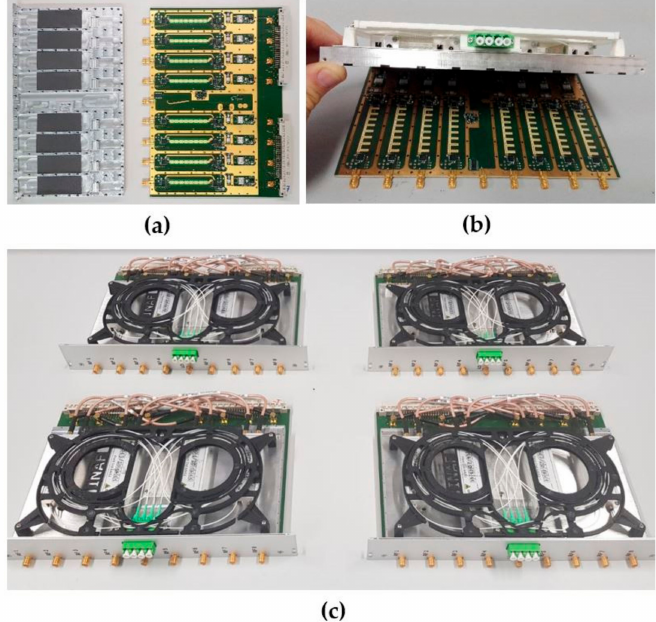
Figure 13. Photos of the WS RF / IF module. ( a ) Mechanical housing (Left) and PCB (Right) before assembly. Microwave absorbers are glued in the pockets of the PCB mechanical housing to mitigate cavity resonances on the RF circuitries. ( b ) PCB board (first prototype version) and mechanical housing during assembly with optical transmitters. ( c ) Four fully assembled WS RF / IF modules, with OTXs sandwiched between mechanical housing and plastic supporting four routing the optical fibers to the quad LC / APC